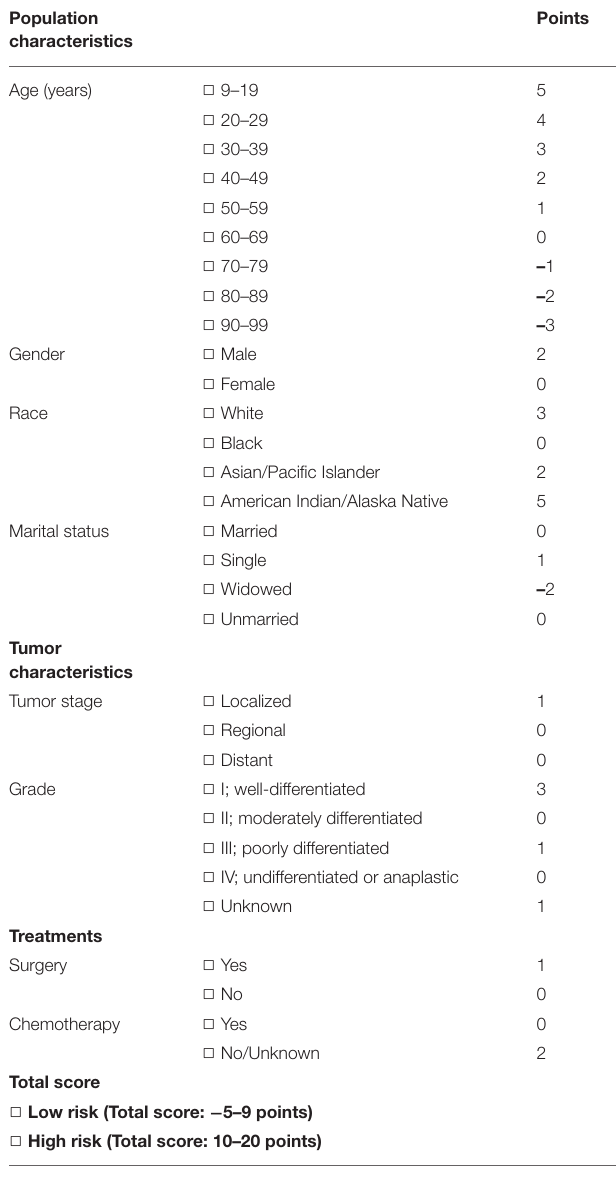
TABLE 4 | A SEER scale for screening suicide of NEN patients. Population characteristics